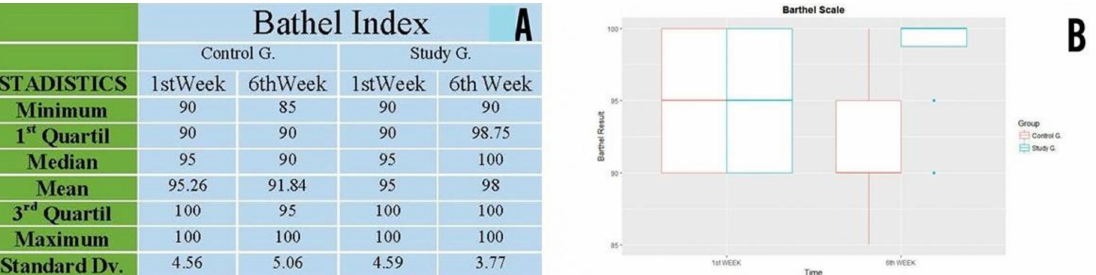
Figure 9. ( A ) Statistical description of the Barthel Index for control and study groups. ( B ) Results of Barthel Index In week 1 and week 6 for control and study